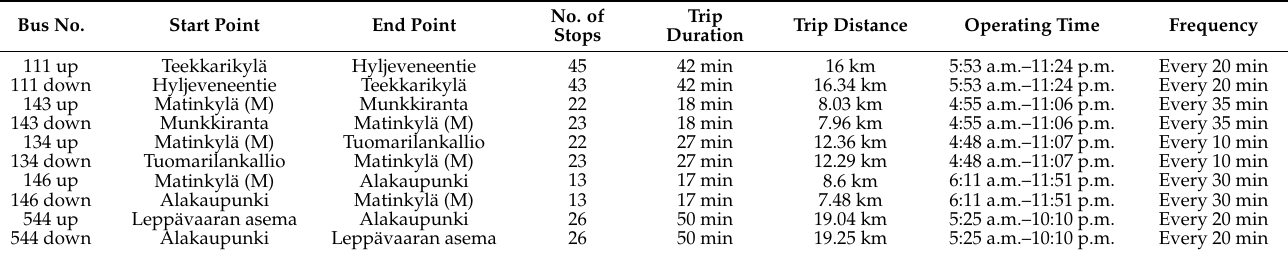
Table 2. Timetable of buses in Route 11 [49].